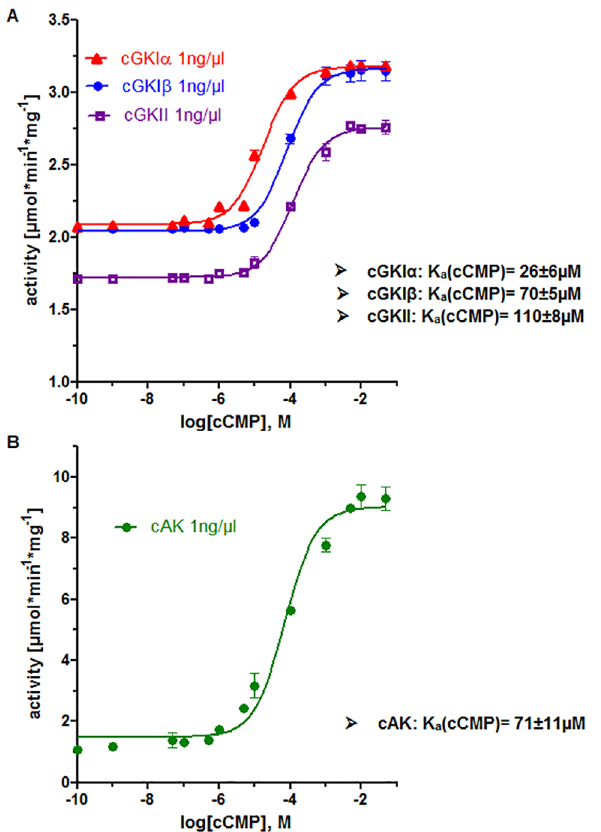
Fig 1. Activation of cGKI α , cGKI β and cAK by cCMP (A) In vitro concentration response curves of purified, recombinant bovine cGKI isozymes and murine cGKII with cCMP as an activator and IRAGtide (RRRVSVAV) as a substrate (B) In vitro concentration response curves of purified, recombinant bovine cAK with cCMP and IRAGtide. Error bars indicate mean ± SEM of three independent